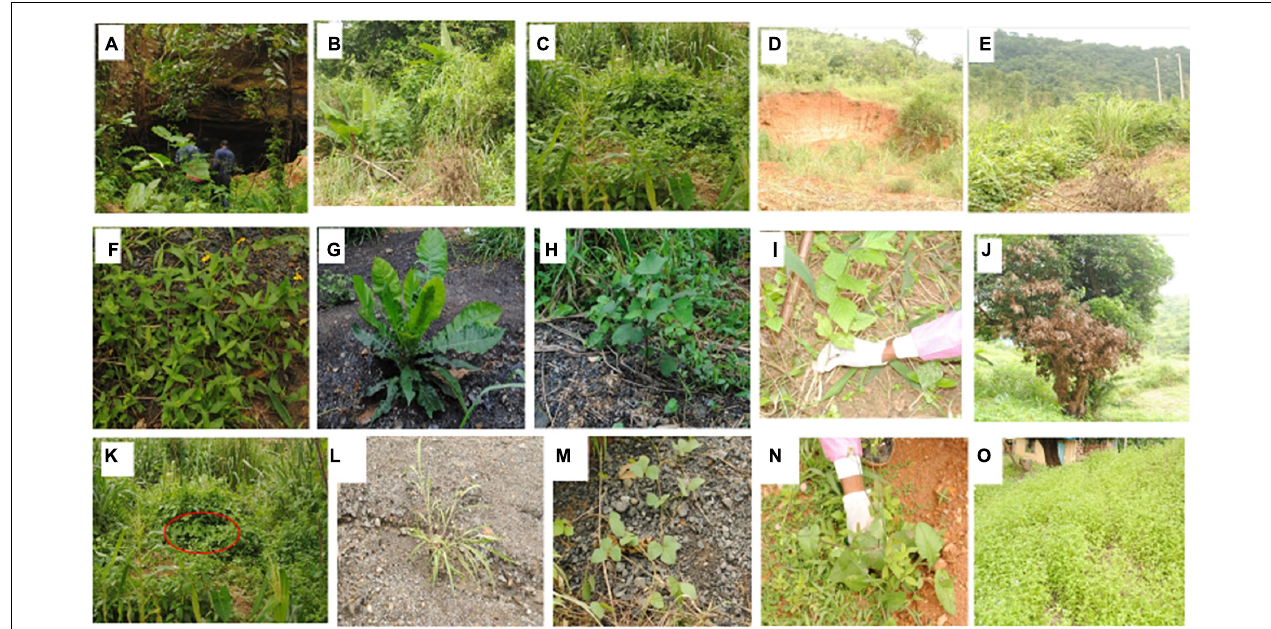
FIGURE 2 | Vegetation view and representative species of the IZ and CZ. (A) Coal cave. (B,C) Disturbed herbaceous vegetation on the coal dumpsite, (D) Hill surrounding area. (E) Physiognomy of the control zone vegetation. (F) Aspilia africana [IZ]. (G) Juvenile Anthocleista vogelii . (H) Urena lobate . (I) Sida acuta .